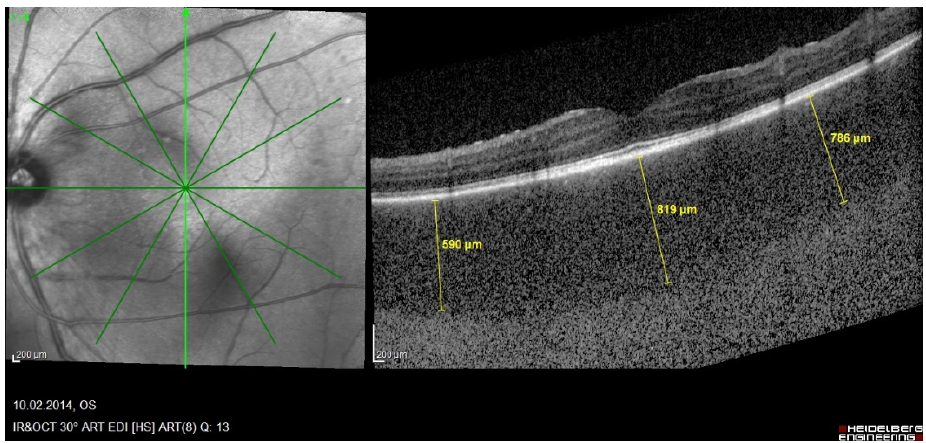
8 of 16 Figure 7. Progression of retinal disease as followed by optical coherence tomography ( x axis indi- cates distance from fovea (=0); y axis indicates thickness of retina in microns). Early disease (green line) features thickening of the retina (and to a lesser degree the fovea). In late disease (yellow line) there is diffuse thinning except in the fovea; foveal thickness remains comparable to normal (pur- ple line) (from Ophthalmic Surg Lasers Imaging 2012; 43-suppl S25–31). Choroidal Enhanced-Depth Imaging OCT (EDI-OCT)